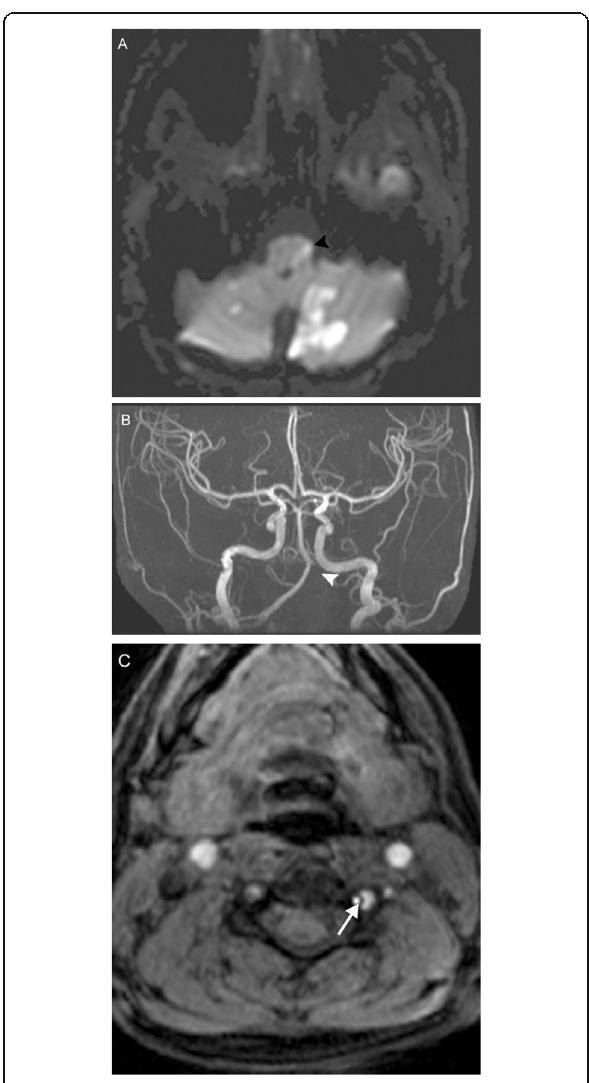
Fig. 11 Lateral medullary infarction. A 33-year-old woman with history of migraines presenting with acute onset vertigo, nausea, weak voice/swallow, and left extremity sensorimotor deficits after chiropractic manipulation. Diffusion-weighted MRI ( a ) reveals numerous acute embolic infarctions involving the bilateral cerebellar hemispheres and bilateral thalami, with notable involvement of the left PICA territory including the left lateral medulla (black arrowhead). TOF MRA MIP image ( b ) reveals absence of flow related enhancement within the left V4 segment and PICA (white arrowhead). Axial TOF image ( c ) reveals small caliber flow within the residual true lumen (white arrow), with surrounding crescentic lower signal in the false lumen. This constellation of findings is consistent with left vertebral artery dissection with showering of emboli resulting in